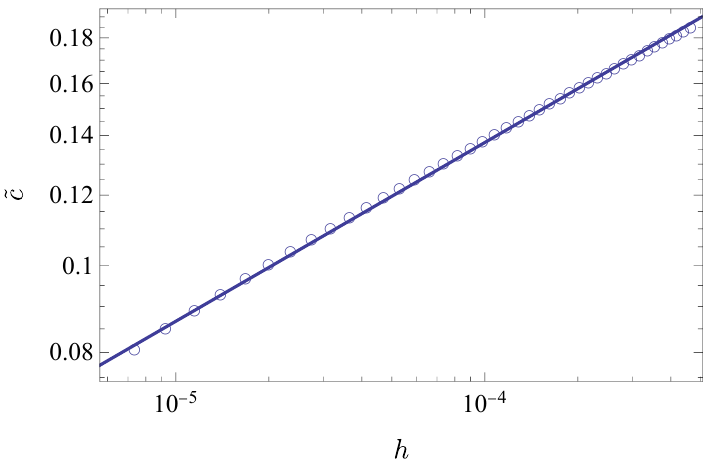
Figure 5 . The critical behavior of the chiral condensate as a function of the quark mass in log scale. The open circles denote the numerical plots, and the solid line denotes the fitting